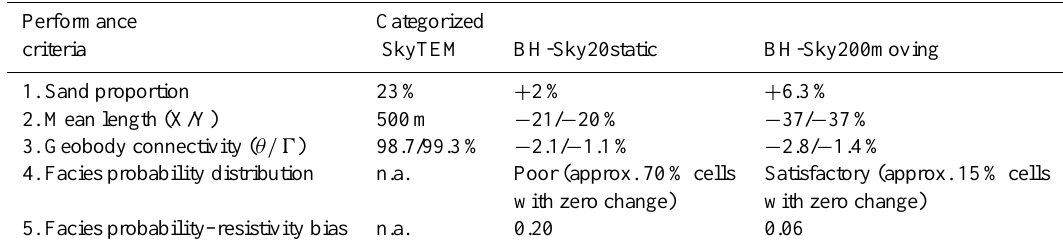
Table 4. The five performance criteria and categorized SkyTEM data as benchmark that are applied to the two simulations with different soft conditioning data sets: cell-by-cell soft conditioning and 200m moving sampling soft conditioning, both including borehole data. The first three criteria are expressed as deviation to the